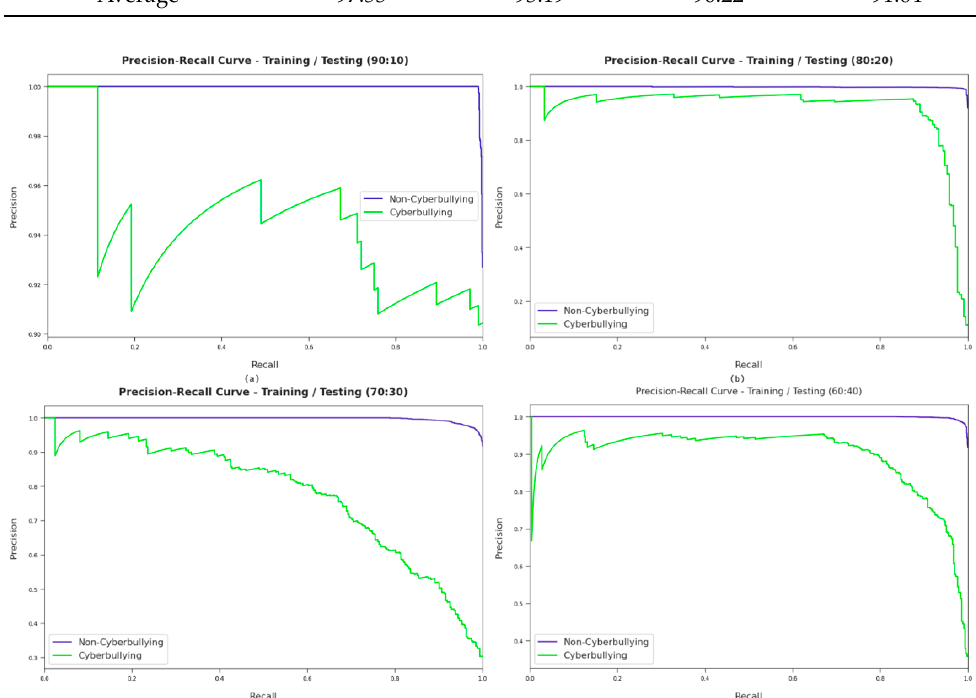
Figure 4. Precision–recall analysis of the proposed model with different training/testing dataset sizes. Where ( a ) considers 90:10 training/testing data split, ( b ) considers 80:20 training/testing data